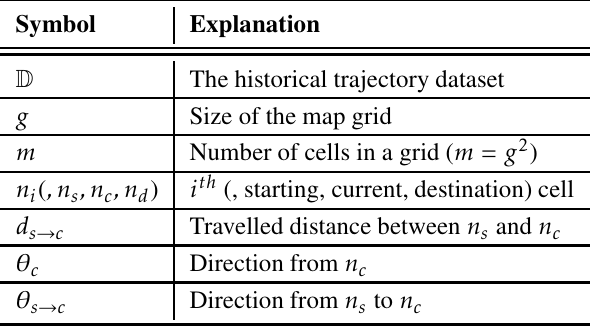
Table 1. Frequently Used